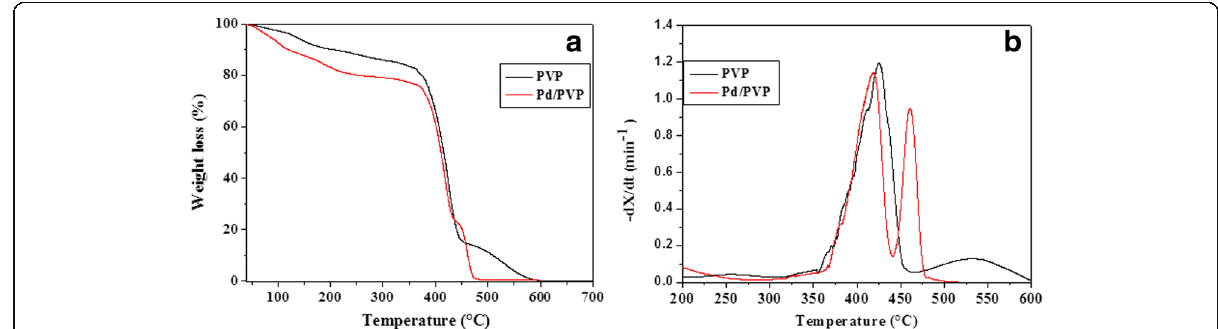
Fig. 3 Weight loss ( a ) and weight loss rate ( b ) corresponding to the combustion of pure PVP (black) and nano-Pd/PVP (red), performed at a heating rate of 10 °C min −